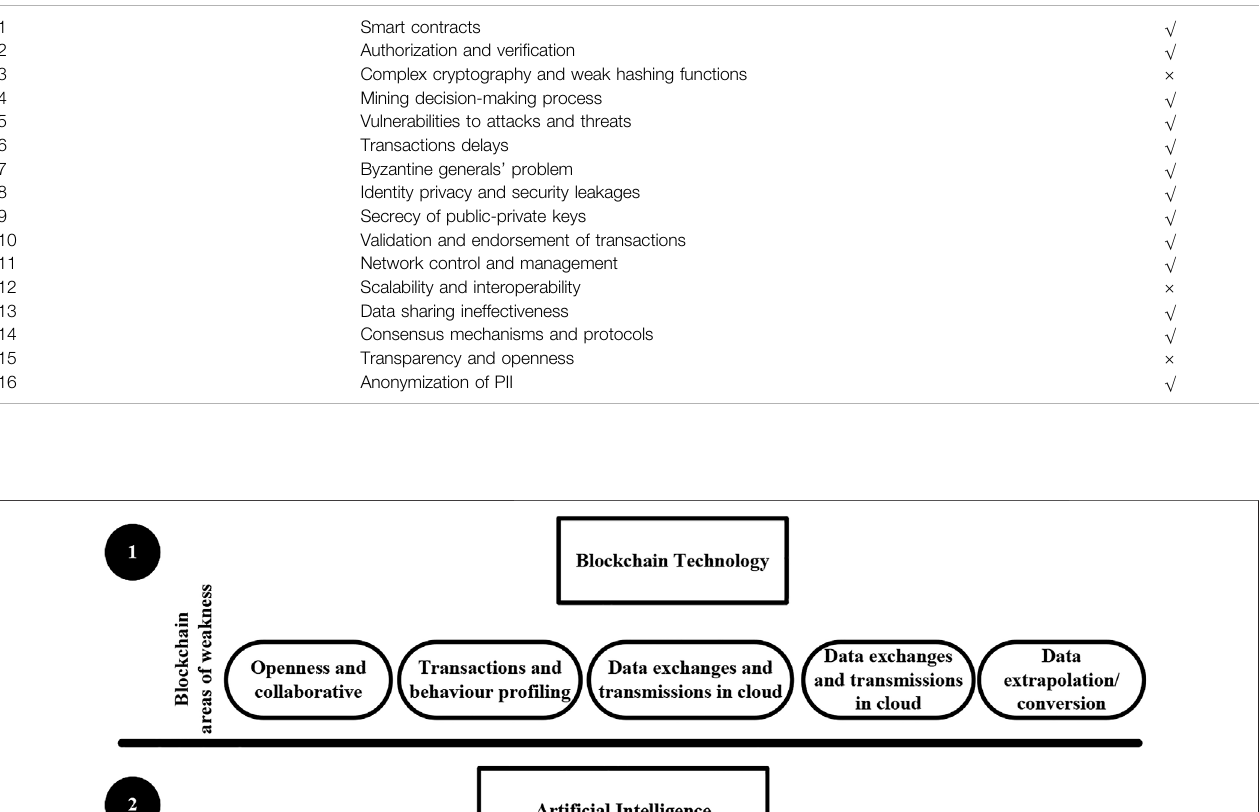
TABLE 1 | Prospects of AI in blockchain technology problems. Tick ( √ ) indicates AI solution probable; tick ( × ) indicates AI solution improbable. S/N